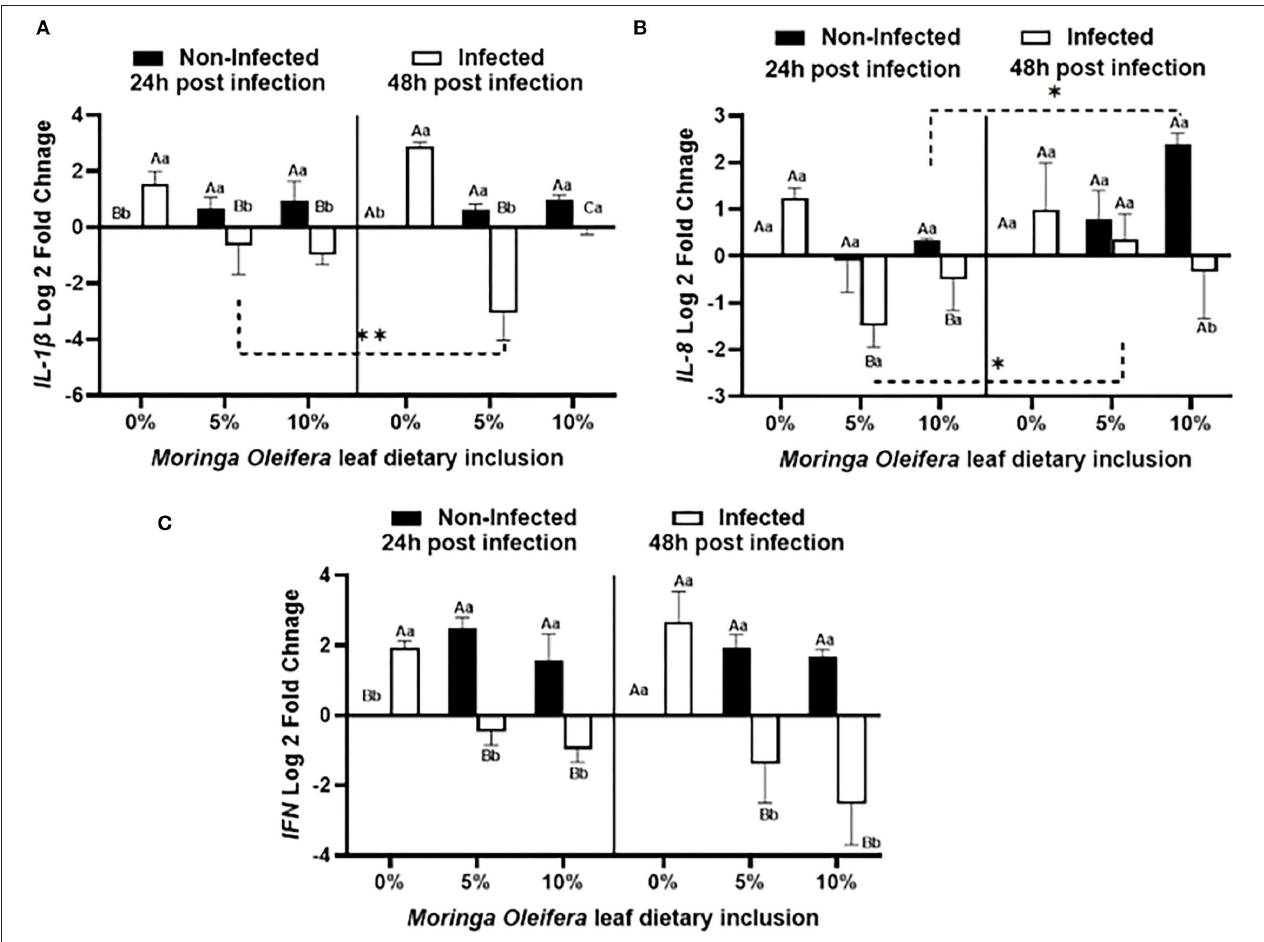
FIGURE 3 | The relative mRNA expression level (6 fish /aquarium) of IL1- β , IL-8, and IFN in the spleen of mono-sex Nile tilapia fed moringa leaf powder dietary inclusion at 0, 5%, and 10% under non-infection and following 24 and 48h post A. hydrophila infection. (A) Represents IL1- β log 2 fold changes. (B) and (C) Show IL-8 and IFN relative mRNA levels (log 2 fold changes). Results are shown as means SEM. Different uppercase letters represent statistical significance at P < 0.05 ± between infection and non-infectious conditions, while lowercase letters denote the statistical significance at P < 0.05 between different moringa inclusion levels. * P <